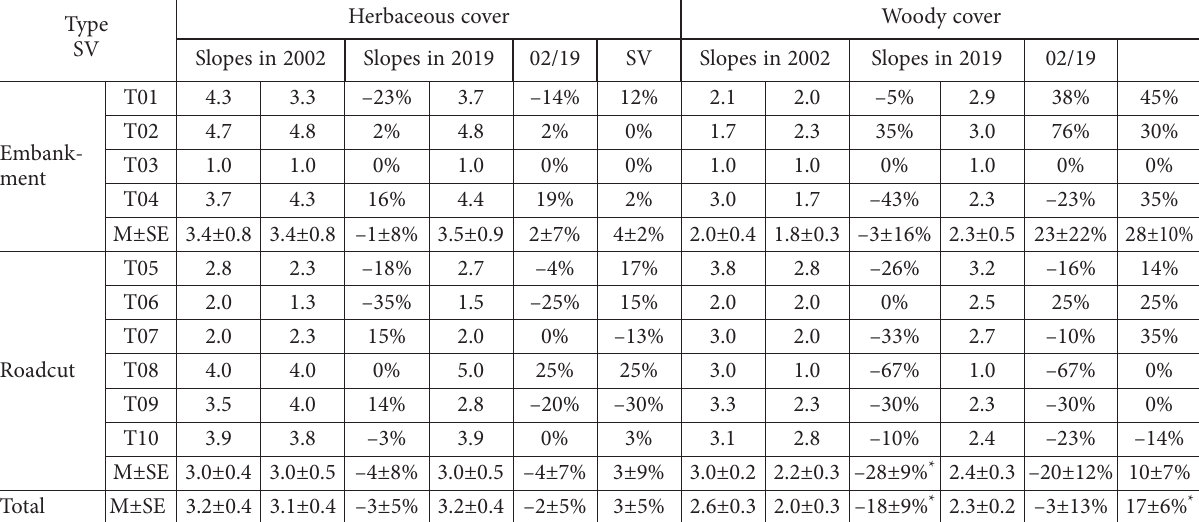
Table 3. Plant cover of surrounding vegetation and changes over time in slope types Herbaceous cover Type SV